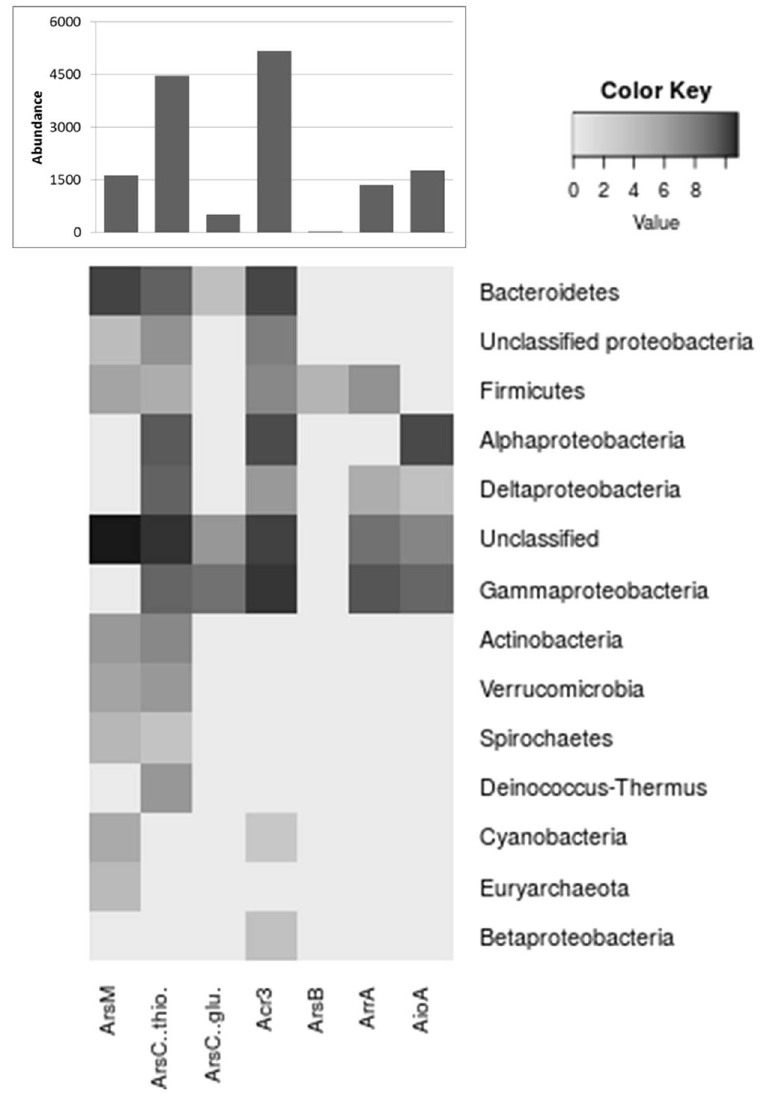
Figure 7. Arsenic genes abundances and affiliation. Counts were log-transformed (log 2 (x + 1)) and drawn as a